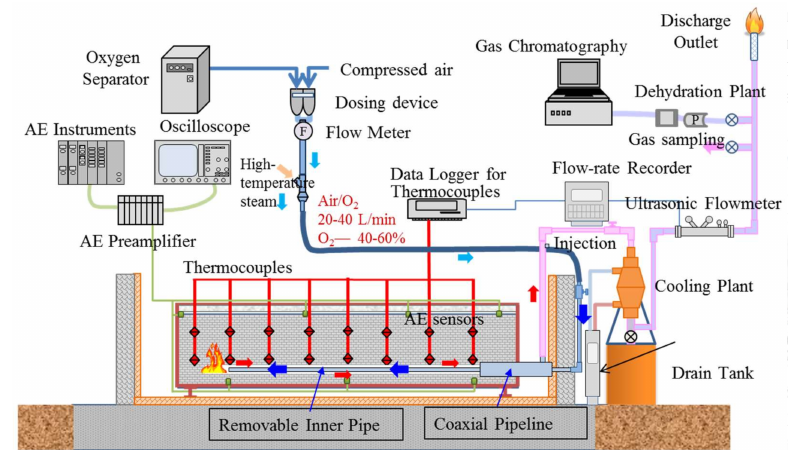
Figure 4. UCG experimental system, the coaxial-hole model.